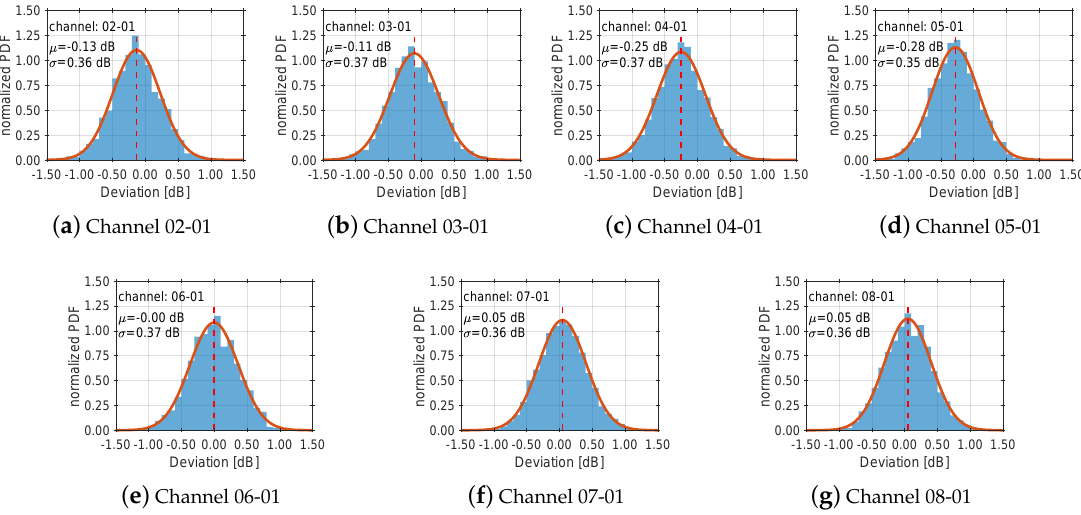
Figure 11. Deviations obtained for the GNSS-signal splitter by laboratory measurements; individual channel variations are summarised w.r.t. their normalised normal probability density function (PDF). The PDFs are referenced to the first channel 01 (DC true) and shown in sufigures ( a – g ) for each combinations in relation to the other inputs of the eight-way splitter (DC false). The impact of the mean µ value and the standard deviation σ are below the level of